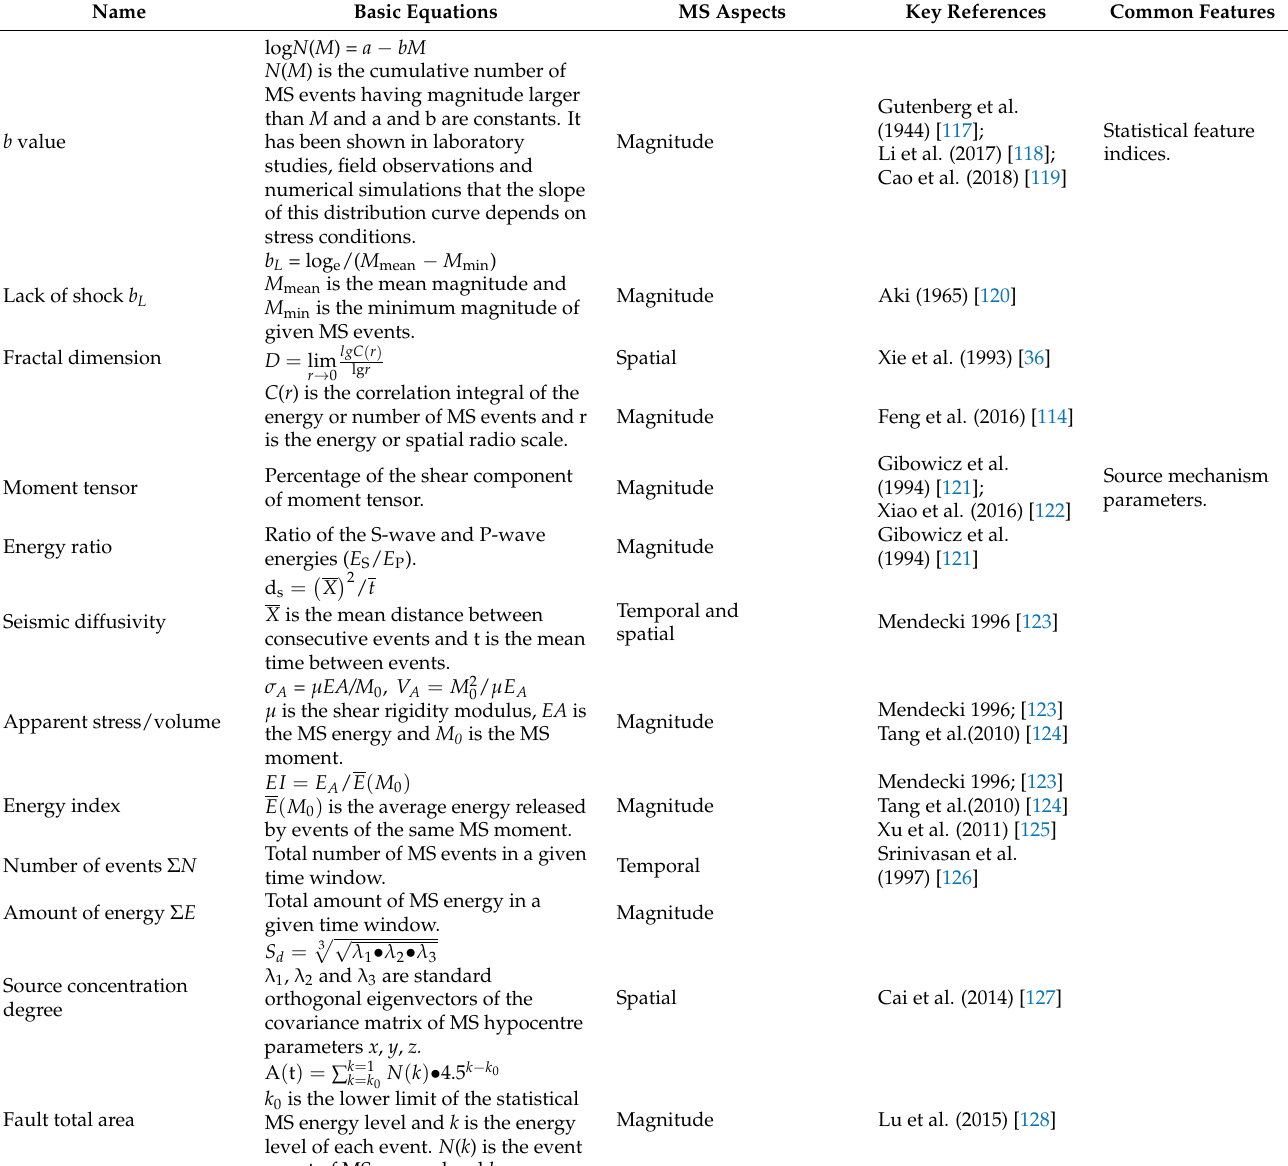
Table 5. Summary of the commonly used MS indices for the forecasting of rockburst (from